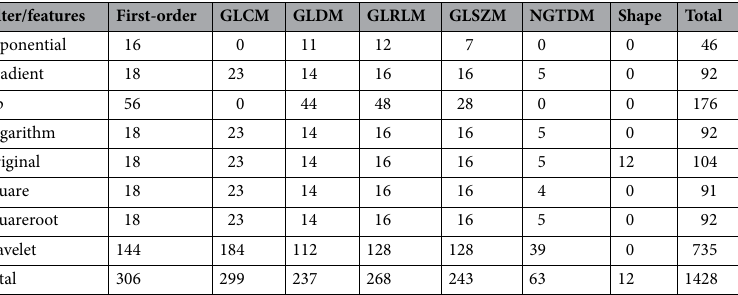
Table 2. Number of radiomics features extracted for different feature classes and image filters. GLCM grey level co-occurrence matrix, GLDM grey level difference matrix, GLRLM grey level run length matrix, GLSZM gray level size zone, NGTDM neighboring gray tone difference